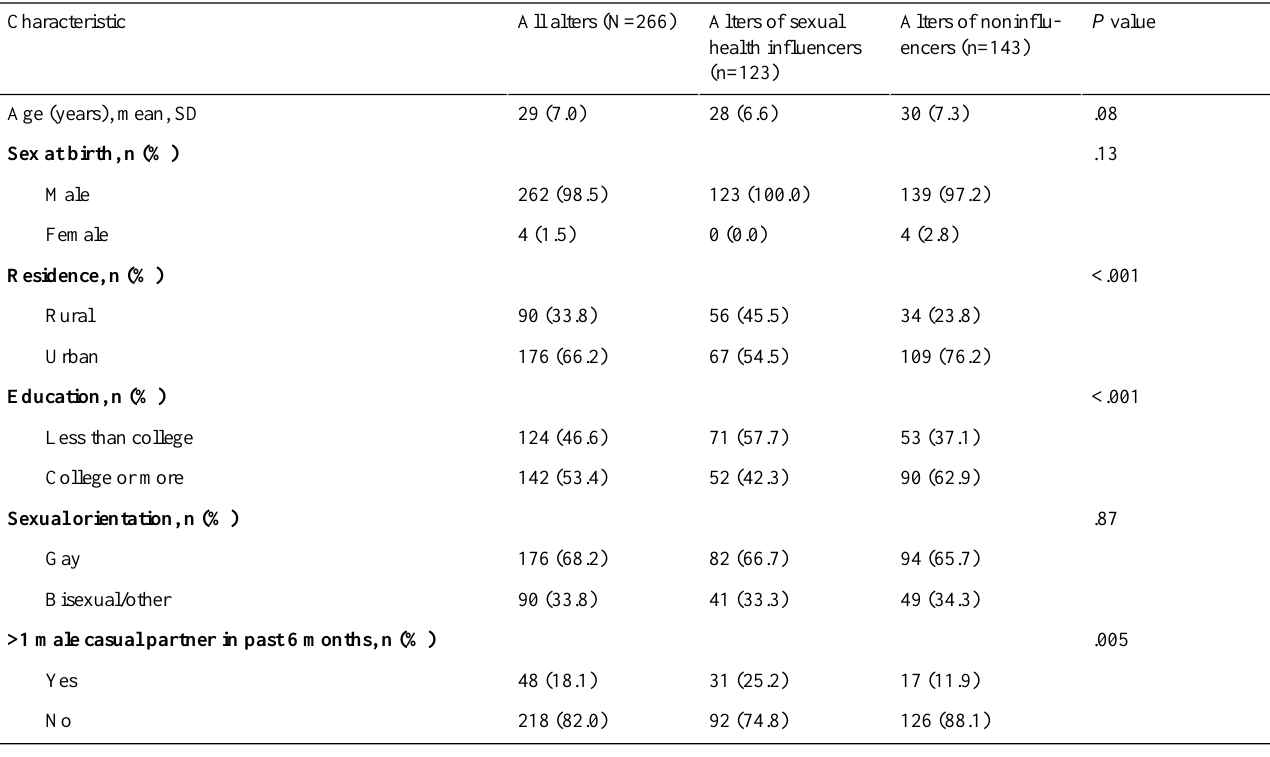
Table 2. Characteristics of responding alter participants in Zhuhai, China, 2018-2019.